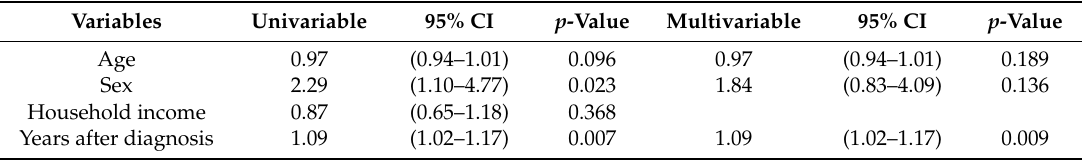
Table 3. The risk factors for ophthalmic follow-up